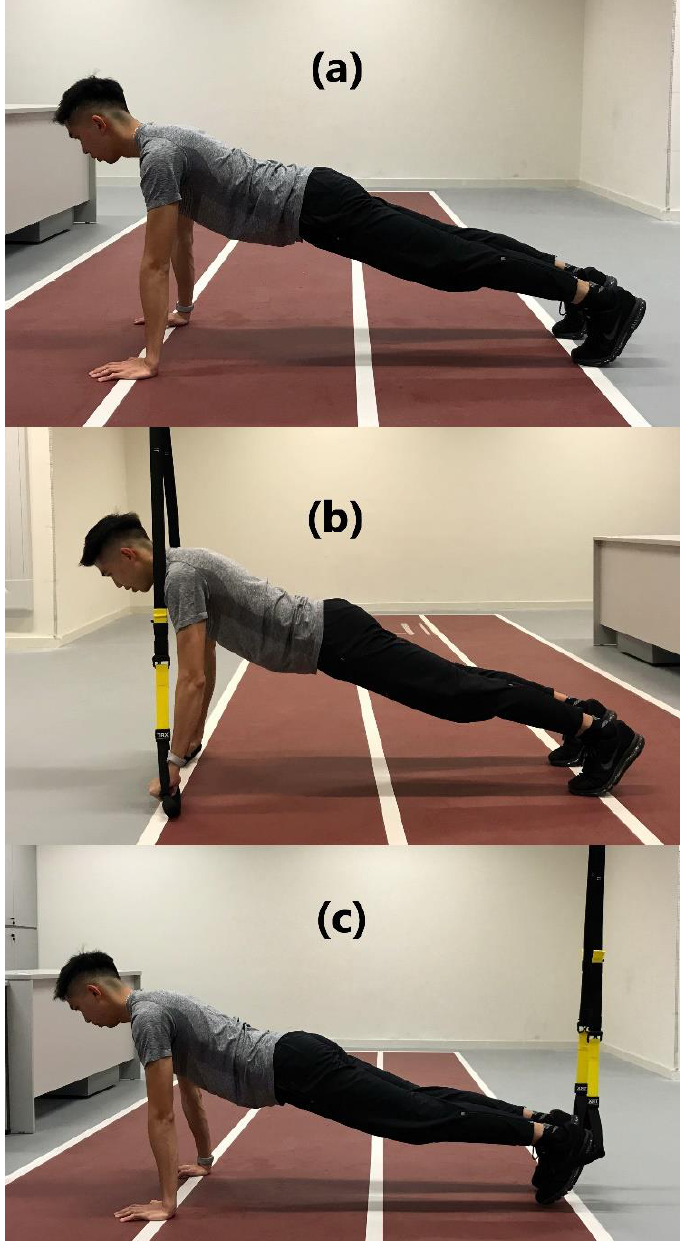
Figure 1. ( a ) Regular prone bridge (Prone con ) is a prone bridge position on an exercise mat with arms held perpendicular to ground level. Only the palms and toes were in contact with the ground. Subjects were instructed to maintain a neutral head and spine with extended leg position throughout the exercise; ( b ) prone bridge with arm suspension (Prone-Arm suspension ) is similar to the regular prone bridge position with the feet placed together on the ground, while the arms were placed inside the suspension straps with a neutral grip position and straight-arm position perpendicular to ground level; ( c ) prone bridge with feet placed on a suspension system (Prone-Feet suspension ) is similar to the regular prone bridge position with palms placed on the ground, while the instep was placed on the suspension straps.